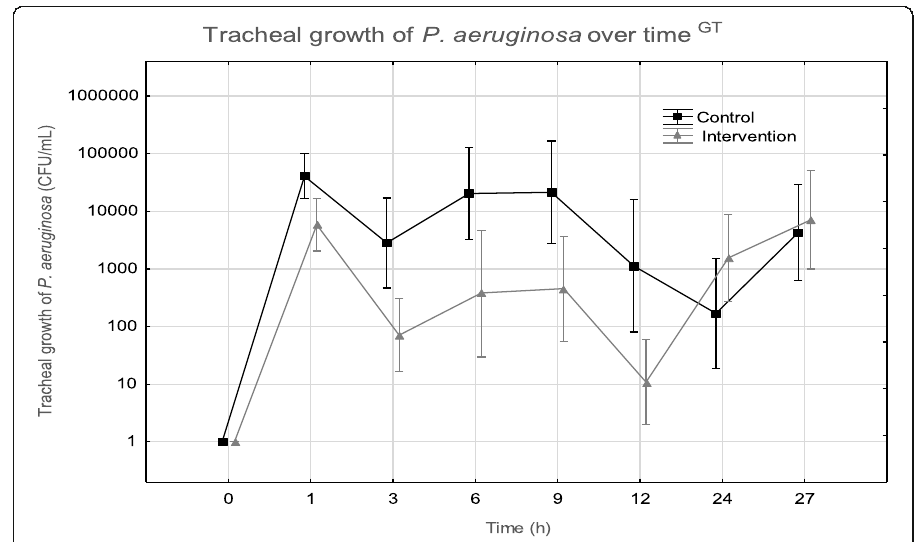
Fig. 2 Tracheal growth of P. aeruginosa over time. Data points represent mean and error bars represent SEM. Black line represents the control group and gray line represents the intervention group. G, significant group difference; T, significant difference over